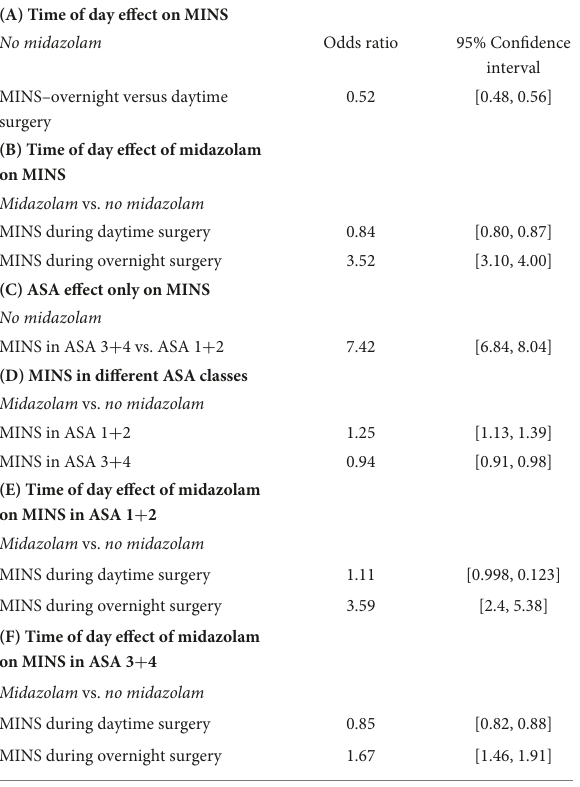
TABLE 1 Effect of circadian physiology on MINS.